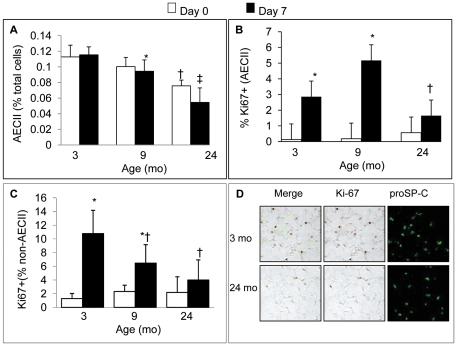
The effect of age on post-PNX cell abundance and proliferation.
A. The effect of PNX on abundance of alveolar type-2 epithelial cells expressed as a percentage of nucleated cells which stained for proSP-C in each age-group, including pre (day 0) and post (day 7) PNX (n = 5 mice/group). * P<0.05 when compared to the 3 mo (day 7) group. † P<0.05 when compared to the 3 or 9 month control (day 0) group. ‡P<0.05 when compared to the 24 mo control group. Data are expressed as means ± SEM. B. Percentage of alveolar type-2 cells (AECII) that were Ki67pos in each age-group pre (day 0) and post (day 7) PNX (n = 5 mice/group). * = P<0.05 when compared to the control within age group; † P<0.05 vs. 9 mo post-PNX data. Data are expressed as means ± SEM; C. Percentage of cells in the alveolar region (excluding AECII) that were Ki67pos in each age-group control (day 0) and post (day 7) PNX (n = 5 mice/group). * = P<0.05 when compared to the control (day 0) values. † = P<0.05 when compared to the day 7 post-PNX data for the 3 mo group. There was no significant difference between the 9 and 24 mo groups. Data are expressed as means ± SEM; D. Representative examples of Ki-67 and pro-SP-C staining in the lung parenchyma after (day 7) PNX in 3 and 24 mo mice.